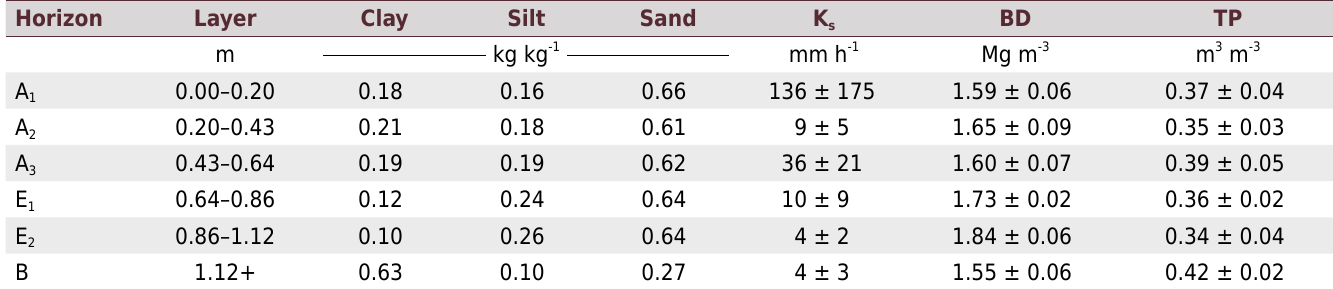
Table 1. Physical properties of the Typic Paleudult soil horizons used in this study. Hydraulic conductivity (K s ), bulk density (BD), and total porosity (TP) are shown as mean ± standard deviation (N = 18)